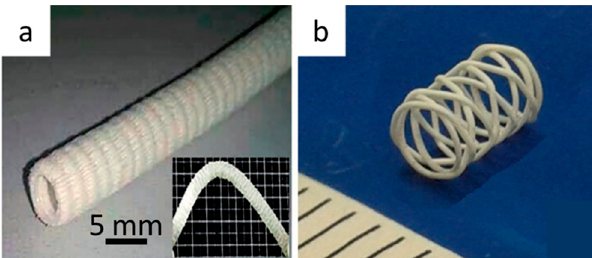
Figure 9. Experimental PHA applications for vessel stenting. ( a ) Macro morphology of corrugated tubular PHBH scaffold obtained via electrospinning (adapted from Reference [139]). ( b ) Representative photograph of a stent 3D printed via CAWS for small-caliber blood vessels (measure unit = 1 mm; adapted from Reference [123]).